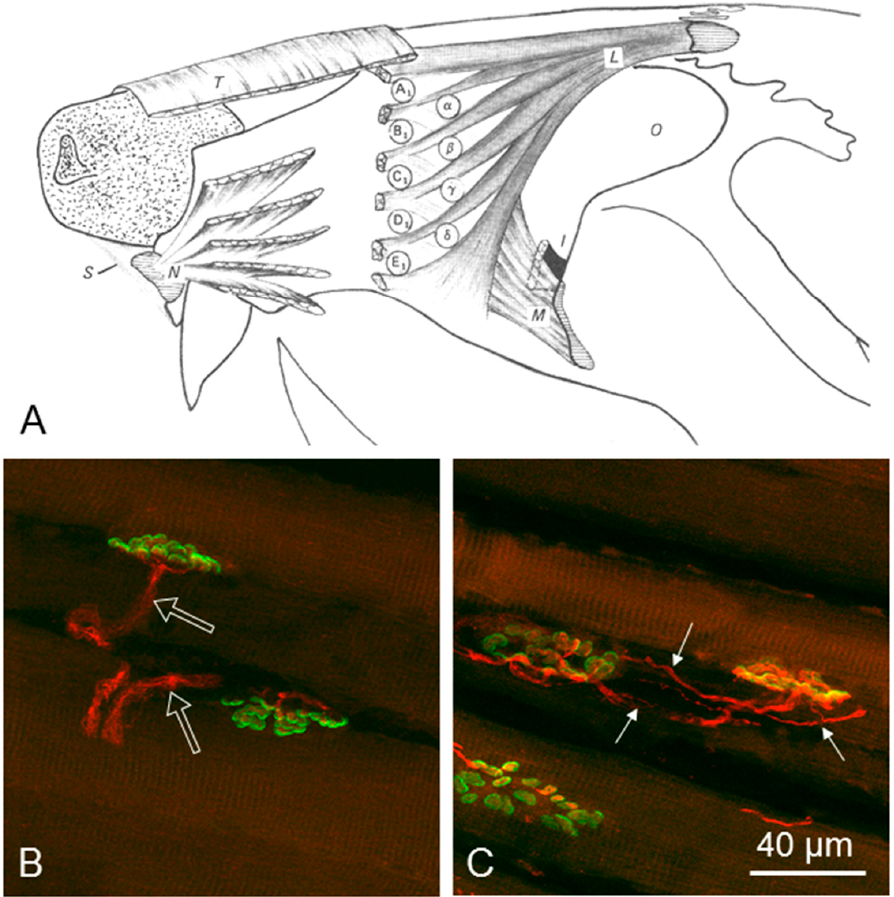
Figure 3. ( A ) Schematic drawing of the extrinsic vibrissae muscles according to Dörfl (1982) [74]: α - δ : the four caudal hair follicles, the muscles slings of which “straddle” the five vibrissae rows ( A 1 – E 1 ), T , transversus nasi muscle; L , levator labii superioris muscle; N , nasalis muscle; M , maxilolabialis muscle; O , orbit; S , septum intermusculare. Panels ( B , C ) show examples of a monoinnervated and a polyinnervated endplate, respectively, where superimposed stacks of confocal images of endplates in the levator labii superioris muscles of intact and surgically treated rats were visualized by staining the motor endplates with Alexa Fluor 488 α -bungarotoxin (green fluorescence), and immunostaining of the intramuscular axons for neuronal class III β -tubulin (Cy3 red fluorescence). Three axonal branches (arrows in ( C )) reach the boundaries of the polyinnervated endplate delineated by the alpha- bungarotoxin staining. In contrast, the normally monoinnervated endplates in ( B ) are contacted by a single axon (empty arrows) with several preterminal rami, whilst in ( C ) the polyneuronally innervated endplate is contacted by three axonal branches. The drawing is from Sinis et al. (2009)